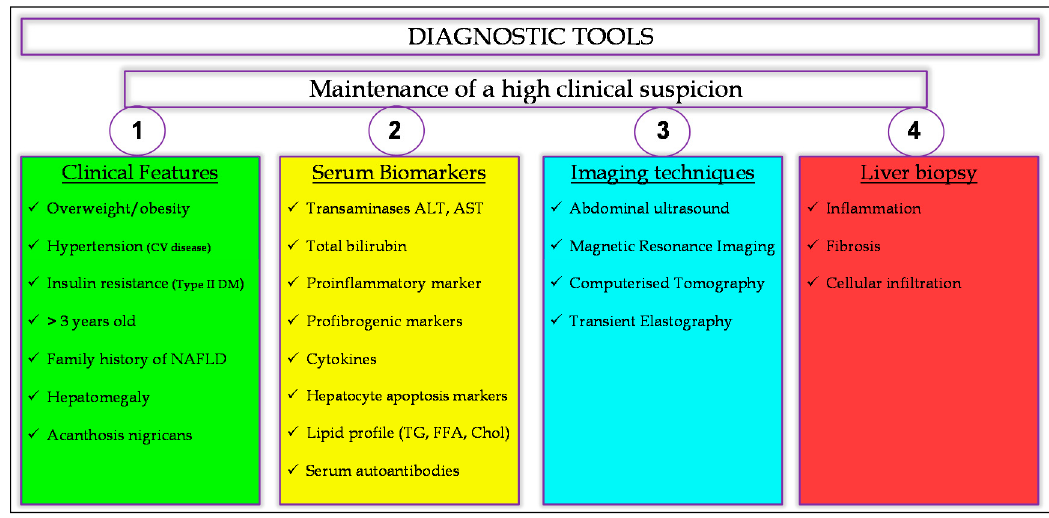
Figure 2. Diagnostic tools for children and adolescent NAFLD. Abbreviations: NAFLD: non-alcoholic fatty liver disease; DM: diabetes mellitus; ALT: alanine aminotransferase; AST: aspartate aminotransferase; TG: triglycerides; FFA: free fatty acids; Chol: cholesterol.